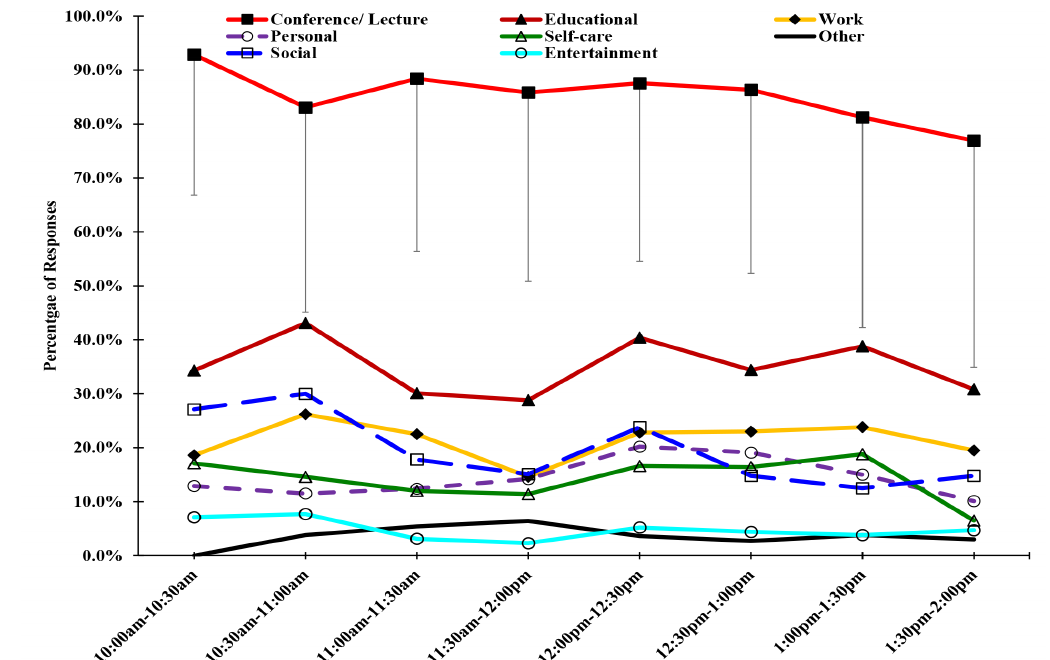
Figure 2: Activities engaged in during the last five minutes by emergency medicine conference attendees, across all polls and all days. Data presented as % of respondents by time of day. Mean conference participation was 85.3% (SD = 35.4%). EM , emergency medicine; SD , standard